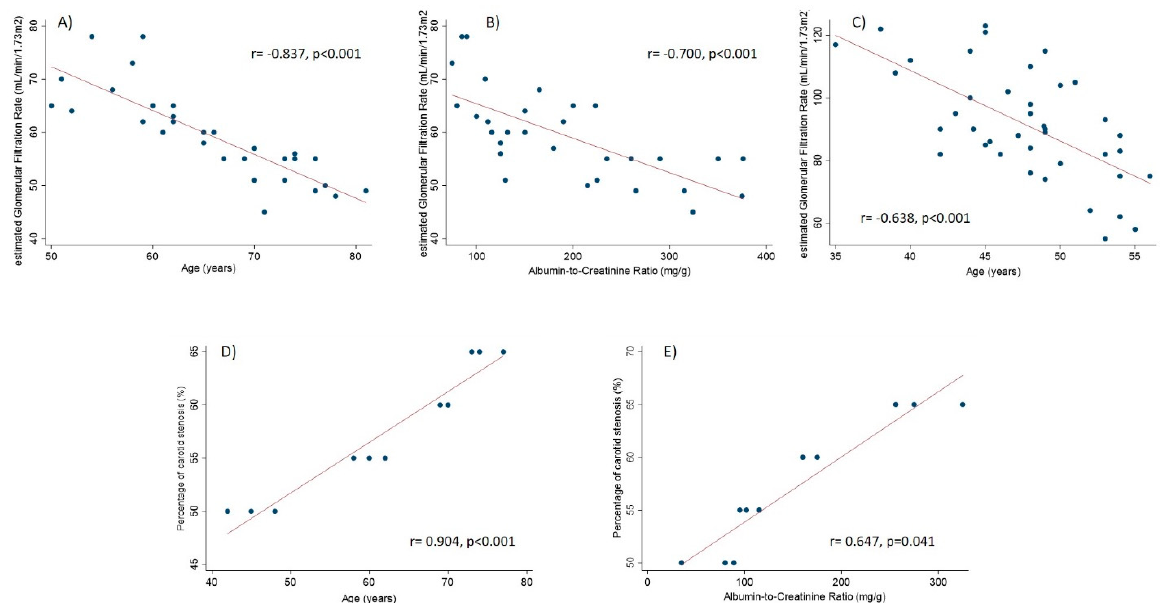
Figure 1. Correlations between the key study variables. Panels A and B refer to AD group. Panel C refers to no-AD group. Panels D and E refer to subgroup with carotid stenosis.